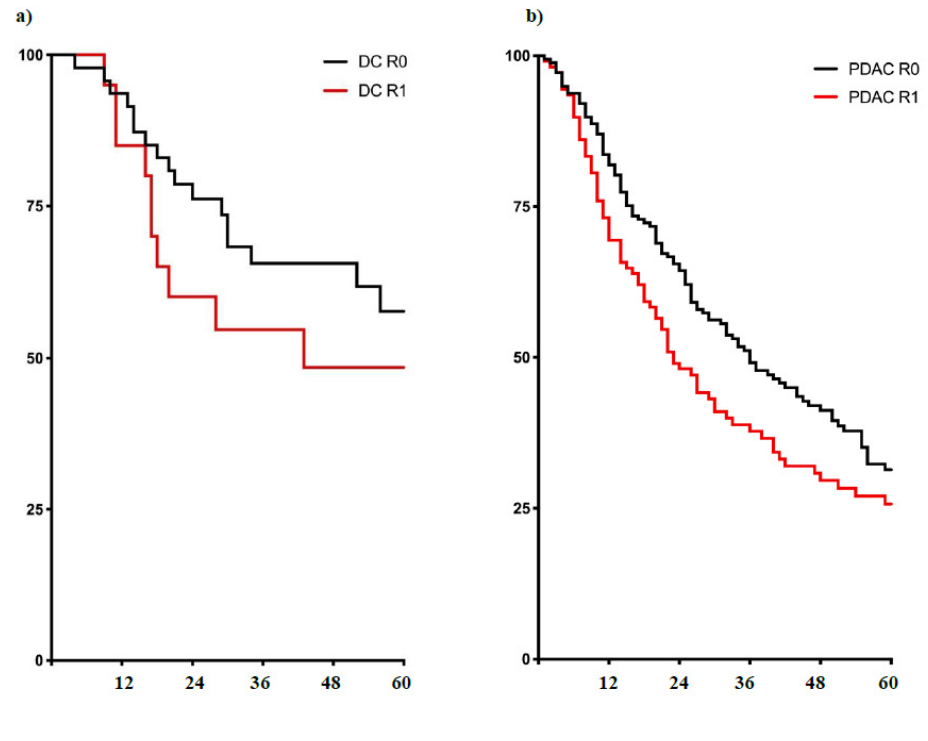
Figure 3. Overall survival among patients who underwent resection for distal cholangiocarcinoma (DC) or pancreatic ductal adenocarcinoma (PDAC).